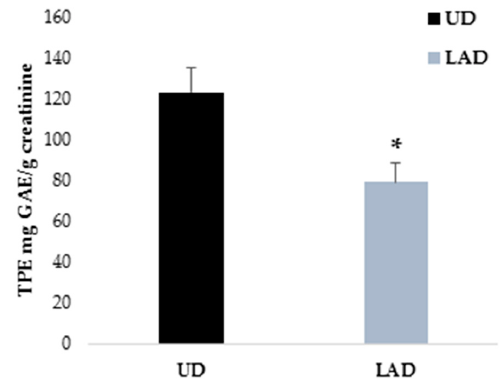
Figure 3. Comparison of total polyphenol excretion (TPE) in urine after each intervention. Data shown are mean ± SEM. * Significant differences with p < 0.05.